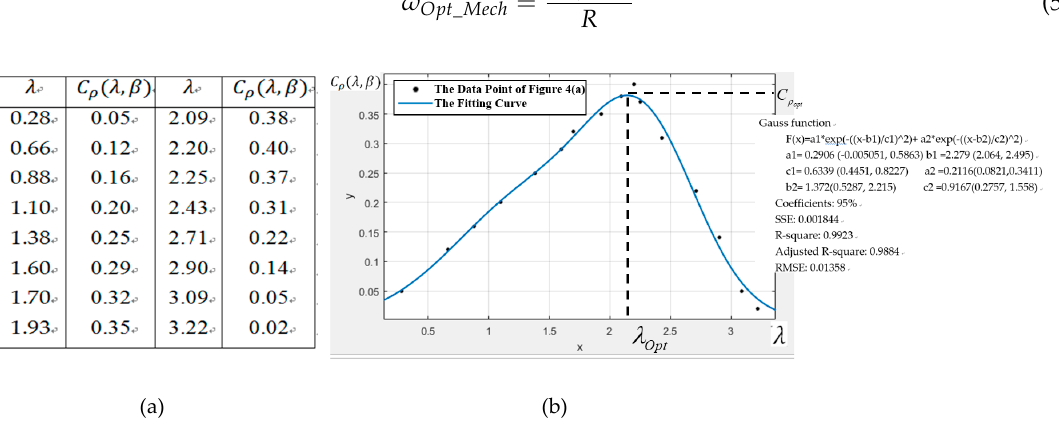
λ ; ( b ) The fitting curve of data points in